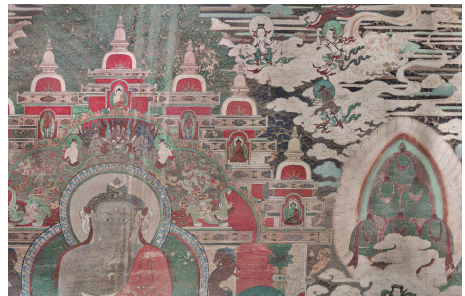
Figure 1 . Mosaic image of murals in the 15th district of the West Corridor of Qutan Temple